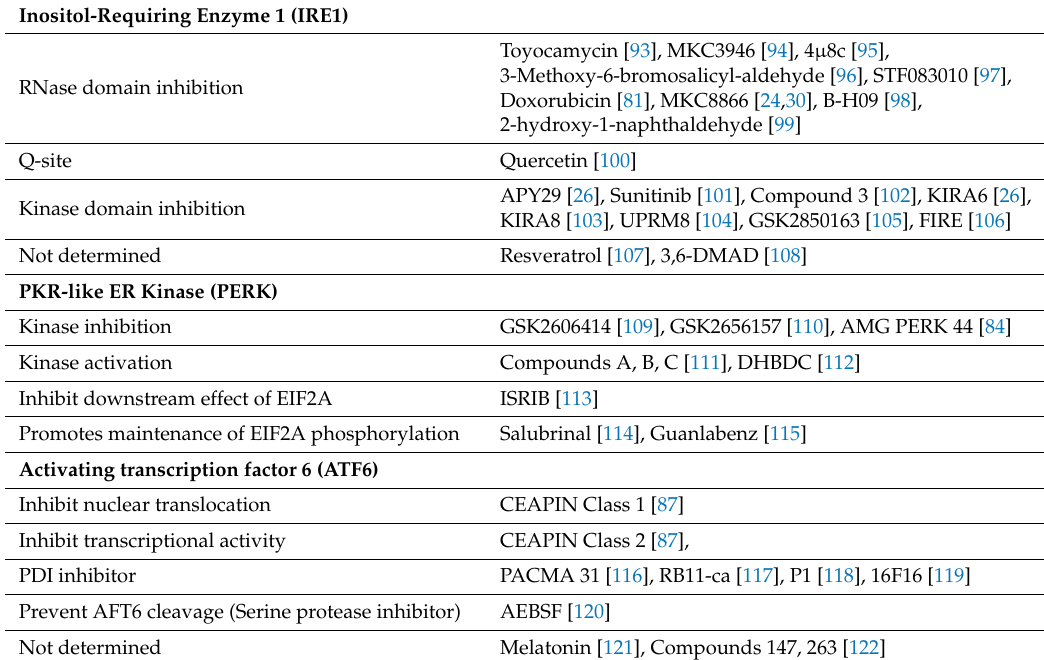
Table 2. UPR Targeting Drugs and their site of